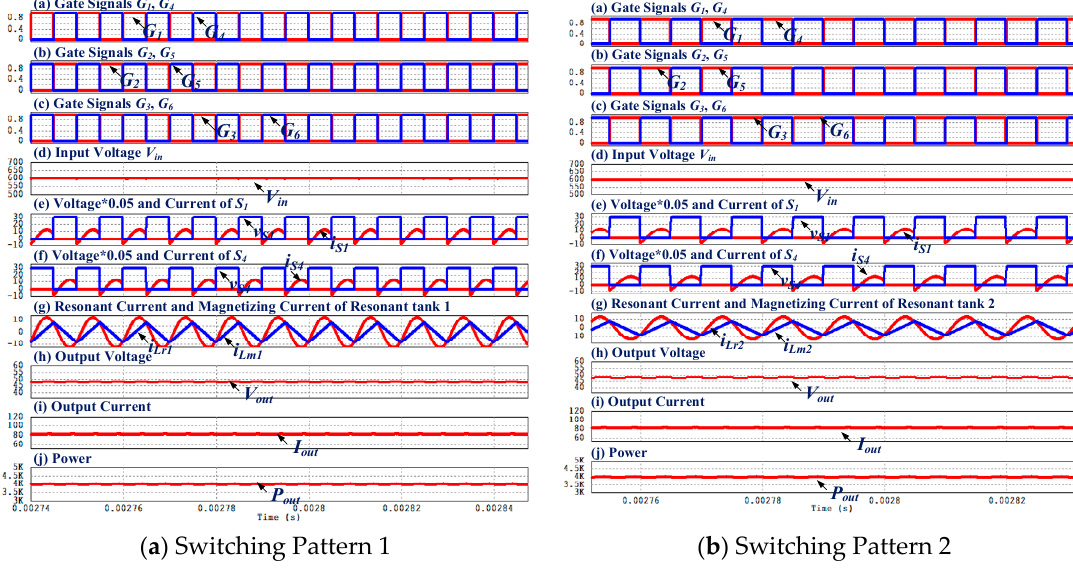
Figure 13. Simulation waveforms of Switching Patterns 1 and 2.